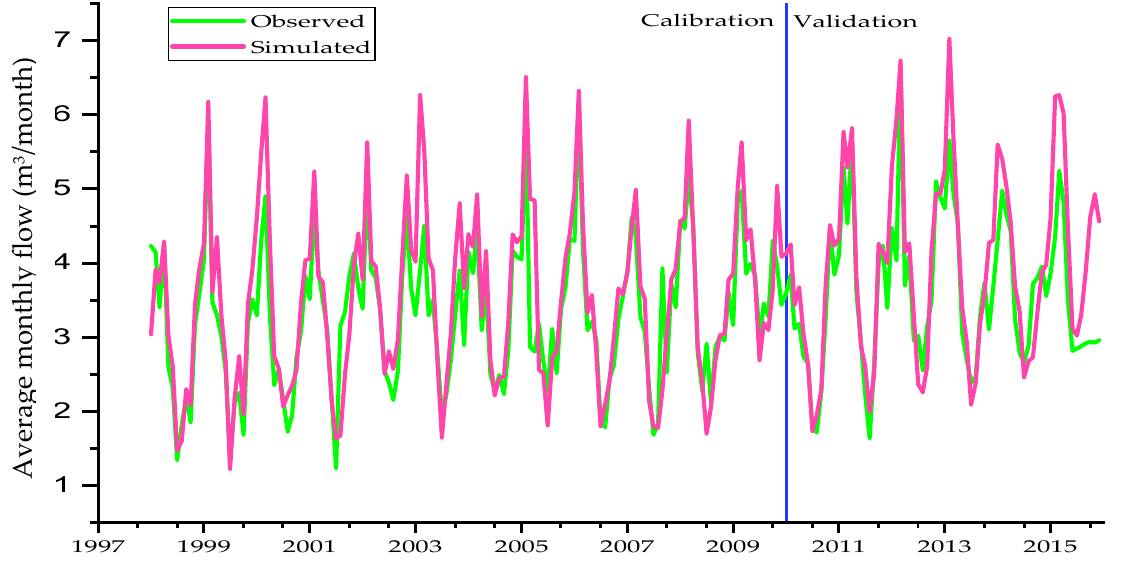
Figure 3. Observed and simulated average monthly flow for Lake Hawassa watershed (calibration and validation).